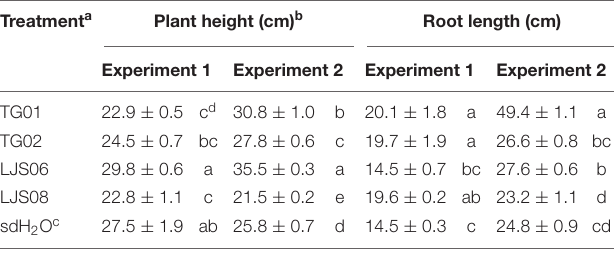
TABLE 2 | Effect of spore suspension of bacterial strains TG01, TG02, LJS06, and LJS08 on plant height and root length of cucumber seedlings. Treatment